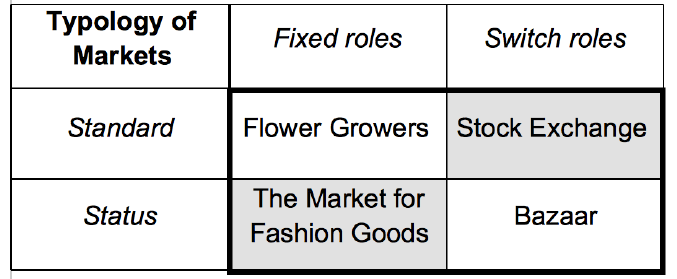
Figure 1. Typology of